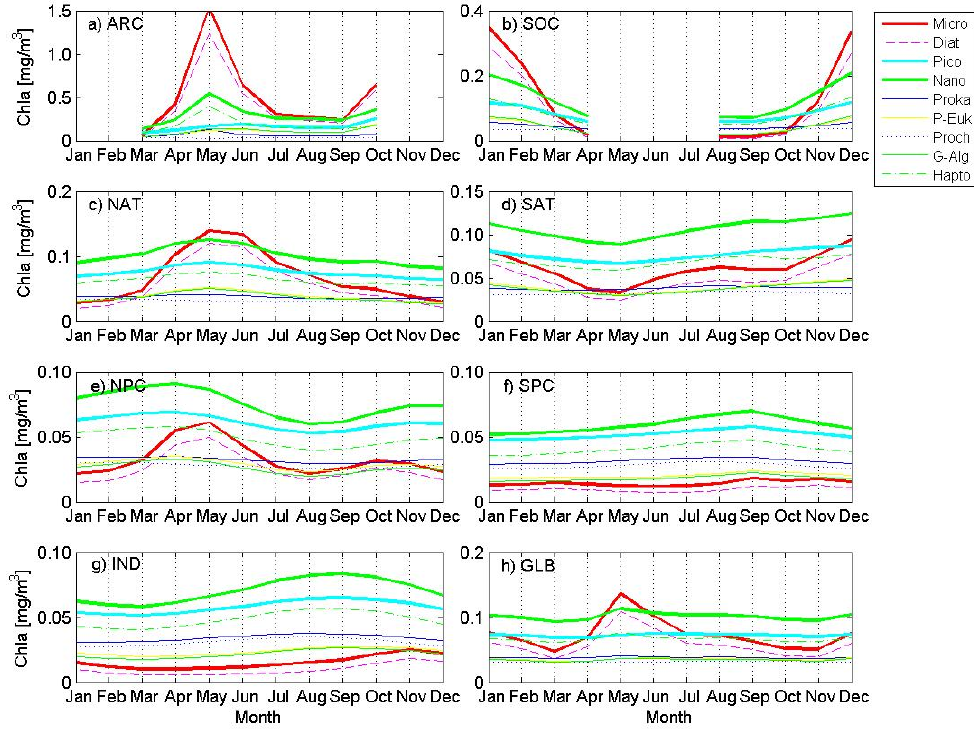
Fig. 8. Monthly climatology of each PSC and PFT derived from SeaWiFS satellite chla over 1998–2009: (a) the Arctic Ocean (ARC), (b) the Southern Ocean (SOC), (c) the North Atlantic (NAT), (d) the South Atlantic (SAT), (e) the North Pacific (NPC), (f) the South Pacific (SPC), (g) the Indian Ocean (IND), (h) the Global Oceans (GLB). For the Arctic and Southern Oceans, the satellite Chl- a is not available for winter period.